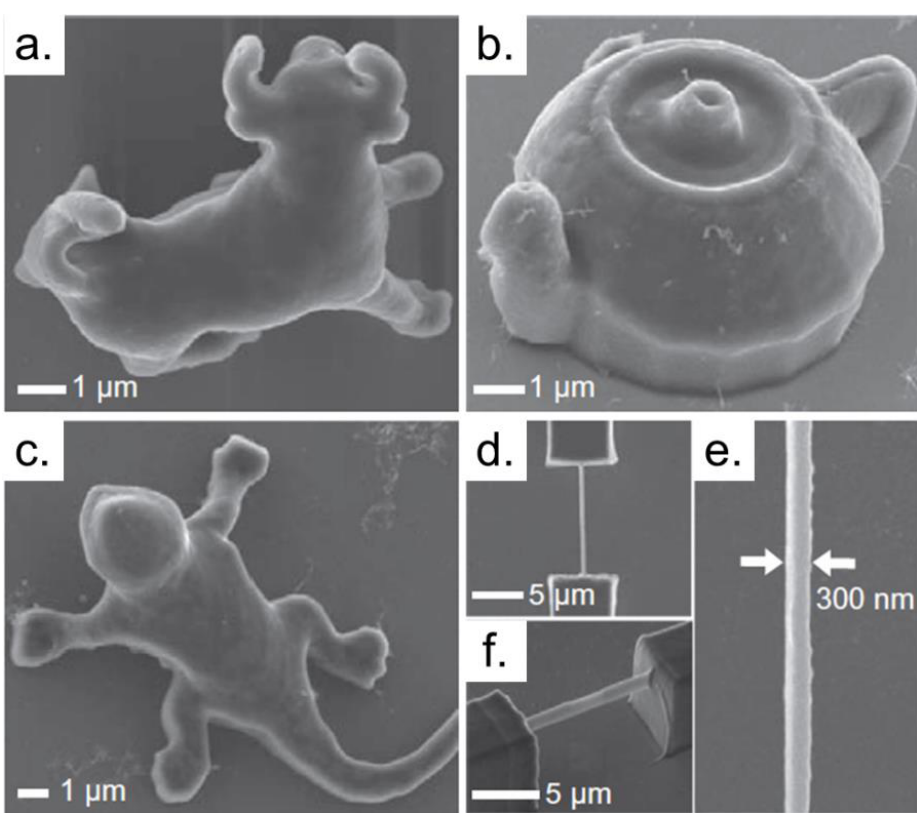
Figure 7. 3D micro/nano structural SWCNT/polymer composites are fabricated by using the TPP lithography. The structures in ( a – f ) are a 8-lm-long micro bull, a micro tea pod, a micro lizard, a nanowire suspended between two micro boxes, magnified image of ( d ), and a perspective view of the nanowire, respectively. Reproduced with permission [87]. Copyright © 2013, Elsevier.